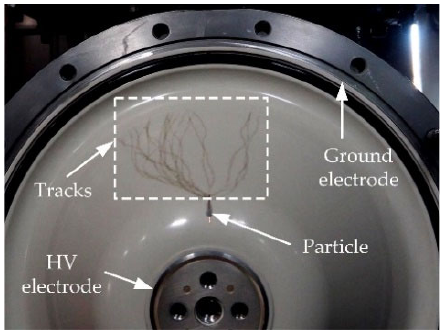
Figure 3. Typical image of tracking on EP sample surface. Only the upper half of the insulator with tracking is shown.